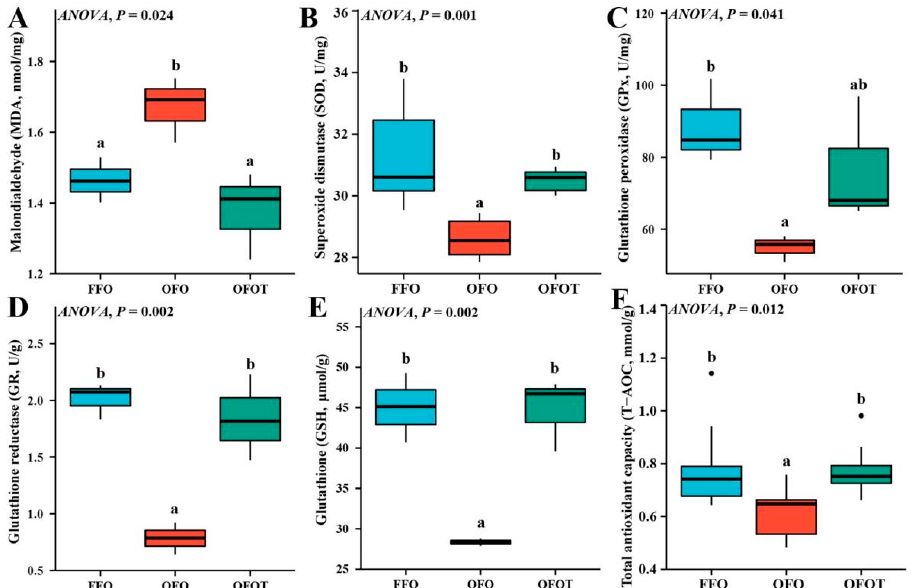
Figure 3. Liver antioxidant indices of channel catfish ( Ictalurus punctatus ) subject to different treat- ment. ( A ) Malondialdehyde, MDA; ( B ) Superoxide dismutase, SOD; ( C ) Glutathione peroxidase, GPx; ( D ) Glutathione reductase, GR; ( E ) Glutathione, GSH; ( F ) Total antioxidant capacity, T-AOC. Data indicate the mean values of three replicate cages per treatment (three fish per replicate breeding barrel). Significance was evaluated by one-way ANOVA ( p < 0.05) followed by Duncan’s multiple range tests. Values marked with different letters are significantly different between the treatment